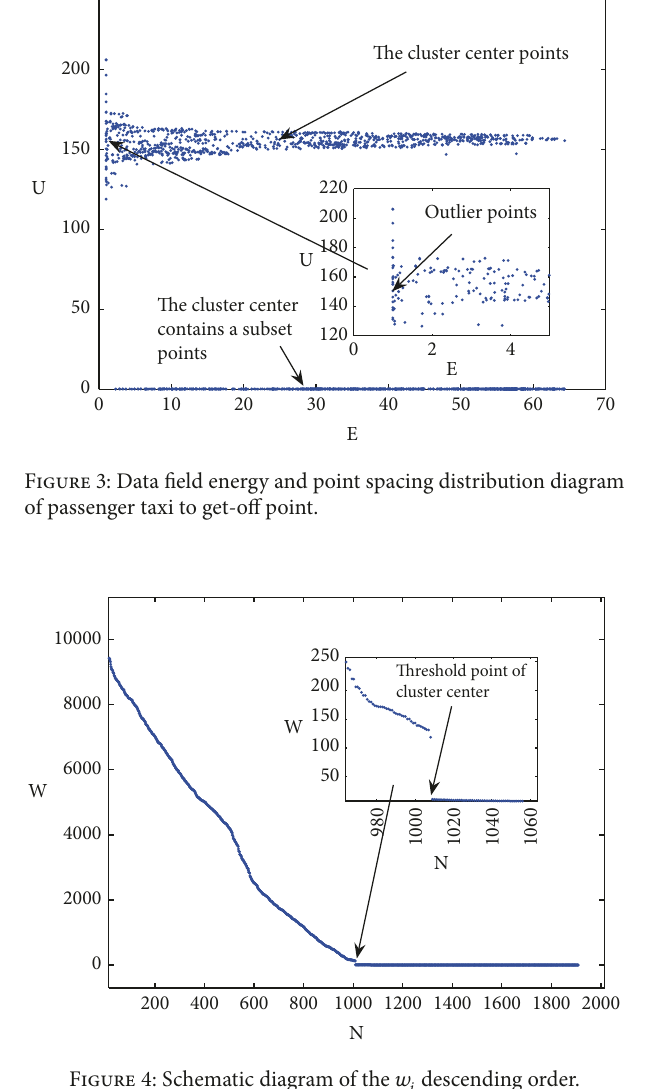
Figure 4: Schematic diagram of the 𝑤 𝑖 descending order.